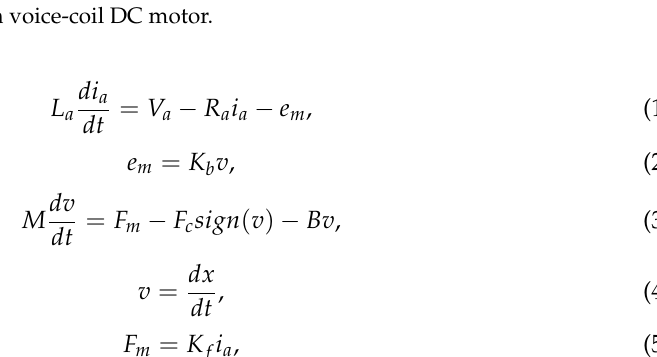
Figure 1. Equivalent model of a voice-coil DC